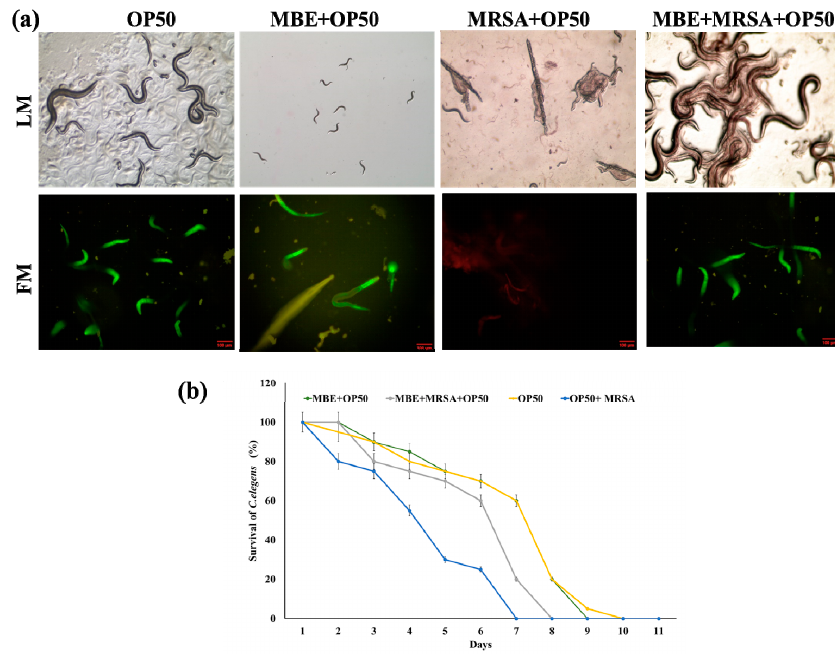
Figure 8. C. elegans life span assay. ( a ) Optical (LM) and fluorescent (FM) microscopic (10x magnification) observation of the live dead C. elegans after the propidium iodide or Syto-9 staining. ( b ) Determination of the C. elegans survival (%) during the 10 days of life span assay. Data are mean ± standard error (SEM, n = 3). * p < 0.01 significantly varied with negative control. OP50— E. coli OP50 normal food diet, MRSA—methicillin resistant Staphylococcus aureus , MBE—methanolic bark extract. The red scale bar in micrographs indicated the length of scale is 100 μ m.